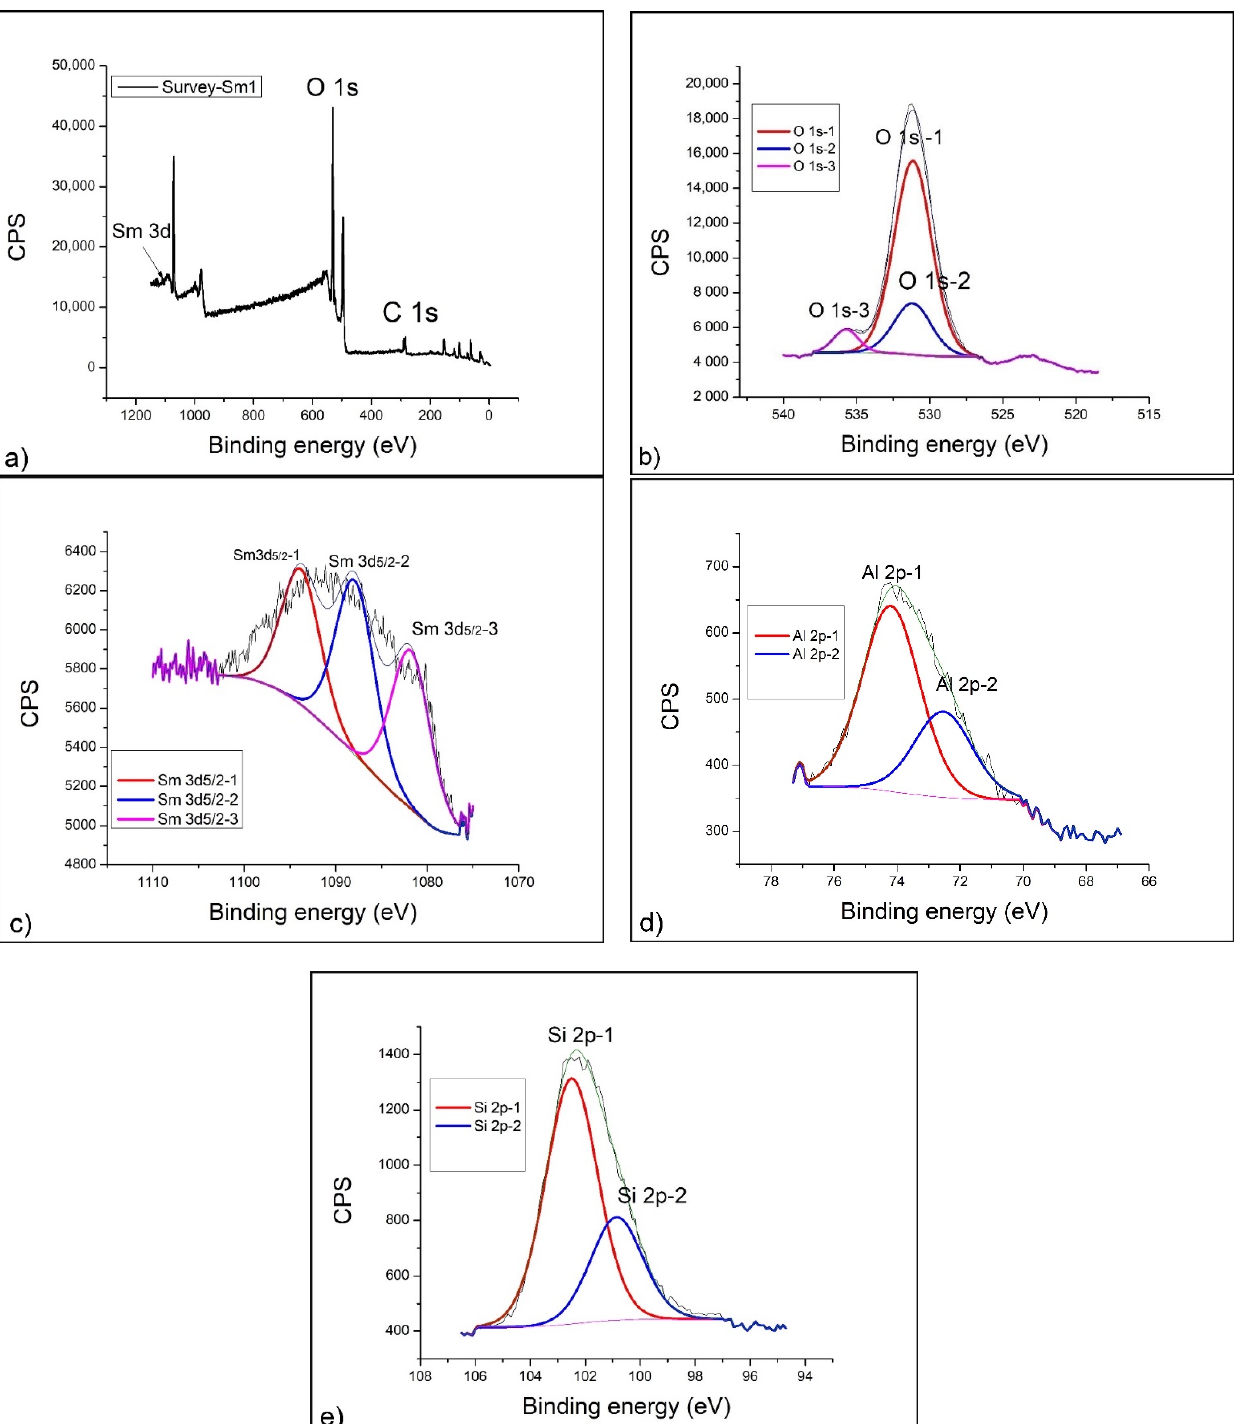
Figure 6. XPS spectrum of GP with 1% Sm: ( a ) Survey spectrum, ( b ) O 1s, ( c ) Sm 3d, ( d ) Al 2p and ( e ) Si 2p . The position of the oxygen spectral line O1s -1 is at the expected place. Detailed analysis (Figure 6b) of this spectral line shows a dominant peak at 531.2 eV corresponding to Al 2 O 3 . Similar to the other samples, the weaker peak at 535.7 eV corresponds to CaAl 2 O 4 and SiAl 2 O 4 . The ratio of amorphous to crystalline Al 2 O 3 also remains unchanged and is 2:1. Figure 6c represents the detailed spectrum of the Sm 3d line. For the purposes of the analysis, only a 3d 5/2 spectral line was used, because it gives a complete insight into the behavior of Sm 2 O 3 when it is affected by a strong base in the process of alkaline activation. Similar to GP with neodymium, samarium also shows a similar tendency to form an un- stable hydroxide at a binding energy of 1088.1 eV (Sm 2 O 3 + Sm(OH) 3 mixture-Sm 3d 5/2 -2) as well as the initial constituent Sm 2 O 3 at 1081.9 eV-Sm 3d 5/2 -1 [55]. Detailed spectra of Al 2p and Si 2p spectral lines (Figure 6d,e) indicate the formation of a complex geopolymer matrix of aluminosilicates. Thus, at a binding energy of 74.2 eV (Figure 6d), the formation of a complex crystal hydrate of Al 2 Si 2 O 7 . 2H 2 O can be noticed with the existence of an amorphous phase of Al 2 O 3 , which is almost always present [56]. The aluminosilicate base of the geopolymer served as a good matrix for incorporation of rare earths (Nd and Sm), and XPS analysis showed that the behavior of these elements is similar in terms of alkaline activation but that neodymium is somewhat more sensitive to strong bases and more transformed into unstable hydroxide Nd(OH) 3 . Samarium (III) oxide (Sm 2 O 3 ) is therefore slightly less soluble in 12M NaOH and, to a smaller extent, con- verted to hydroxide Sm(OH) 3 . The XPS spectral analysis provided full-insight chemical structure information of the Nd- and Sm-doped GP, as shown in Figures 4–6. The intensity of peaks corresponding to Si, O and Al elements changed, indicating the transformation of chemical bond during the doping process. The intensification of O, Si, and Al peaks occurs mainly due to the geopolymerization of aluminosilicate. There are three types of primary chemical states of oxygen in geopolymer including Si-O-Al, Si-O-Si and Si-O-H, with the main spectral line positions at 531, 532 and 533 eV, according to the literature [57–59]. The fitted parameters of the O1 s XPS spectra are shown in Figures 4, 5 and 6b for GPNd and GPSm, respectively. There are more Si-O-Al and Si-O-H chemical bonds in GPSm, which is in accordance with the FTIR results. 2.5. TEM Analysis The geopolymer samples incorporated with 5% of Nd 2 O 3 and Sm 2 O 3 were addition- ally analyzed using transmission electron microscopy (TEM). The given images at magni- fication 11kx of both samples and X-ray energy dispersive spectrum (EDS) that is acquired on the same images are shown in Figures 7 and 8.